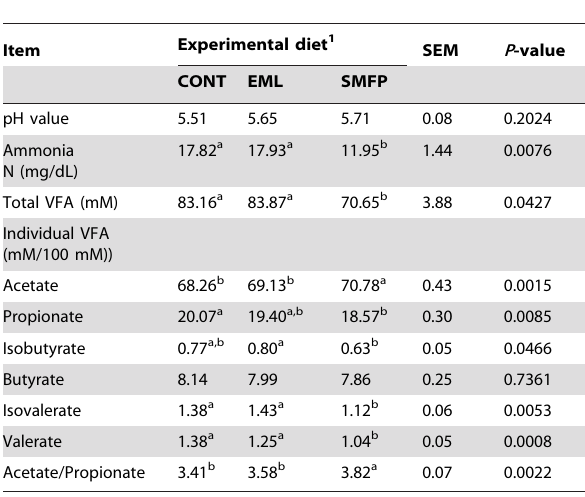
Table 3. Rumen fermentation of finishing steers fed a total mixed ration supplemented with ensiled mulberry leaves (EML) or sun-dried mulberry fruit pomace